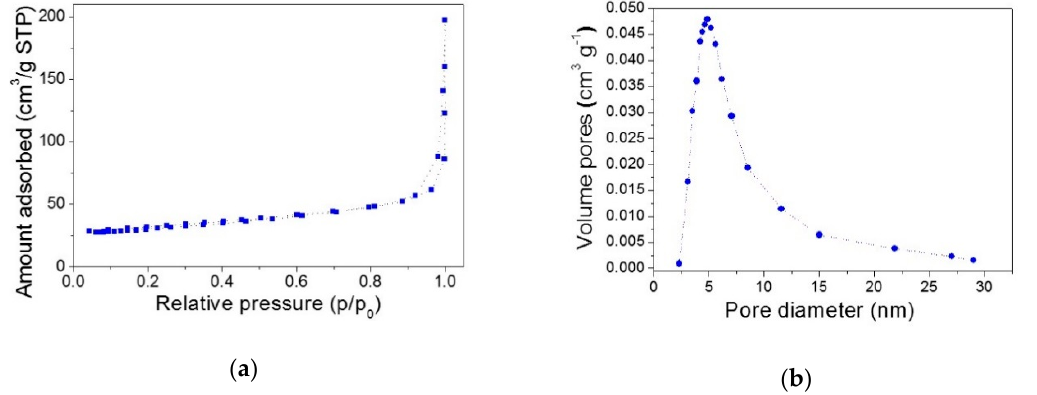
Figure 3. N 2 adsorption / desorption isotherm ( a ) and pore size distribution ( b ) of SCFC-SP20 as a representative sample.